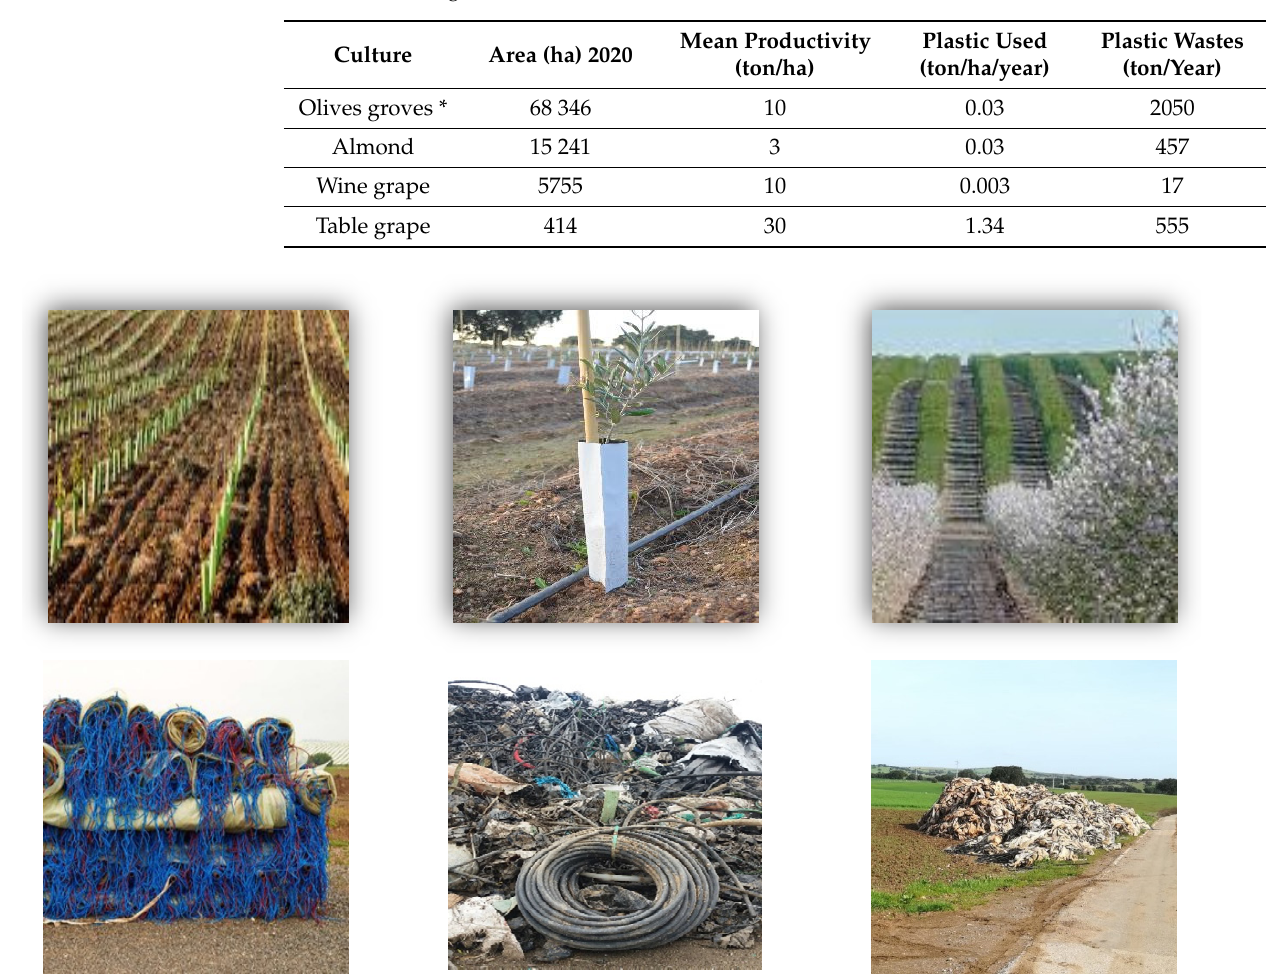
Figure 2. Photos from the cultures more present in the Alqueva Dam irrigation region and examples of waste plastics produced.